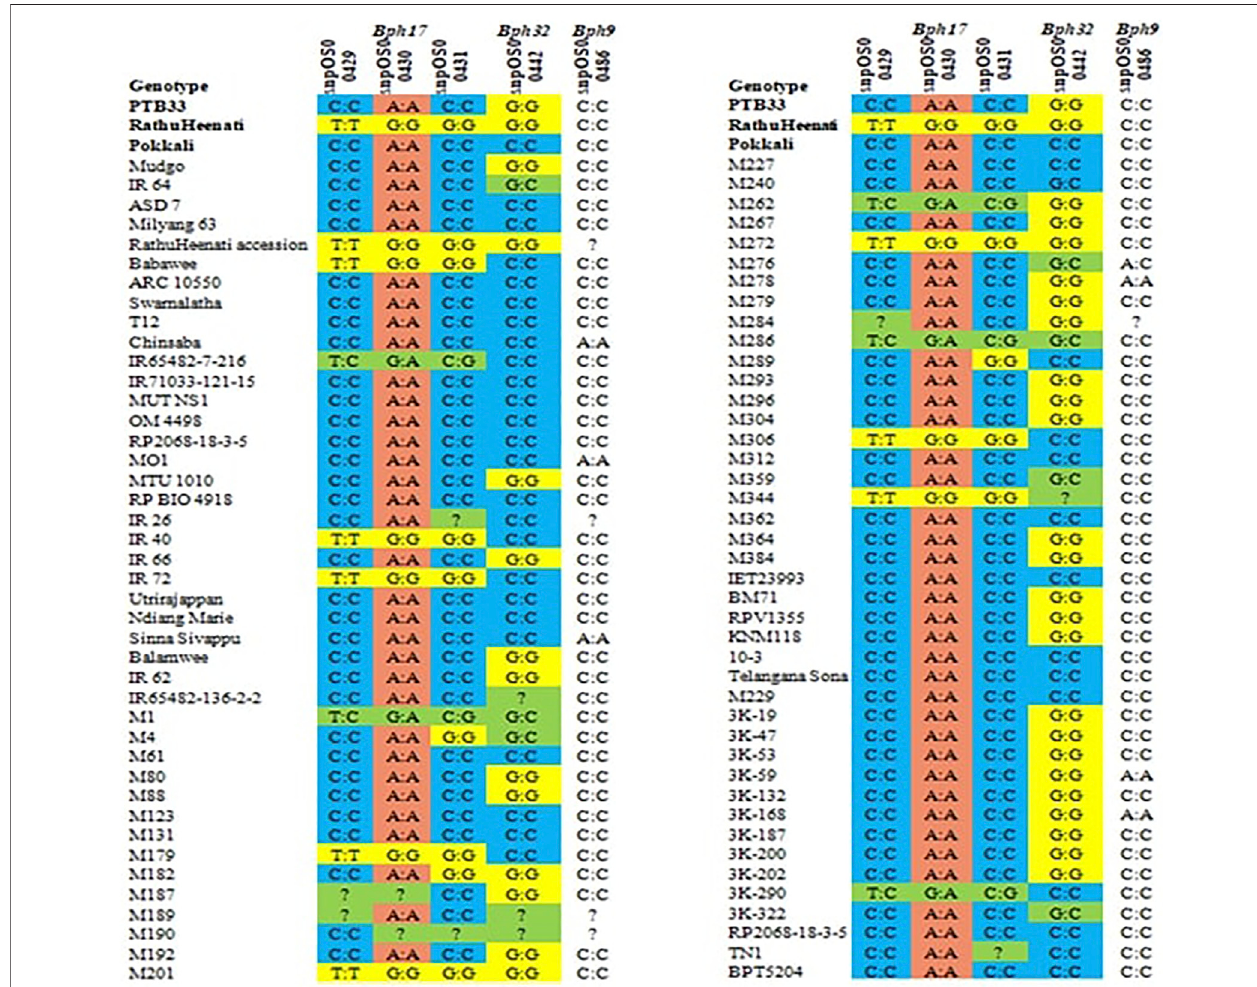
FIGURE 5 | Validation of Bph17 , Bph32 and Bph9 SNPs in genotypes.